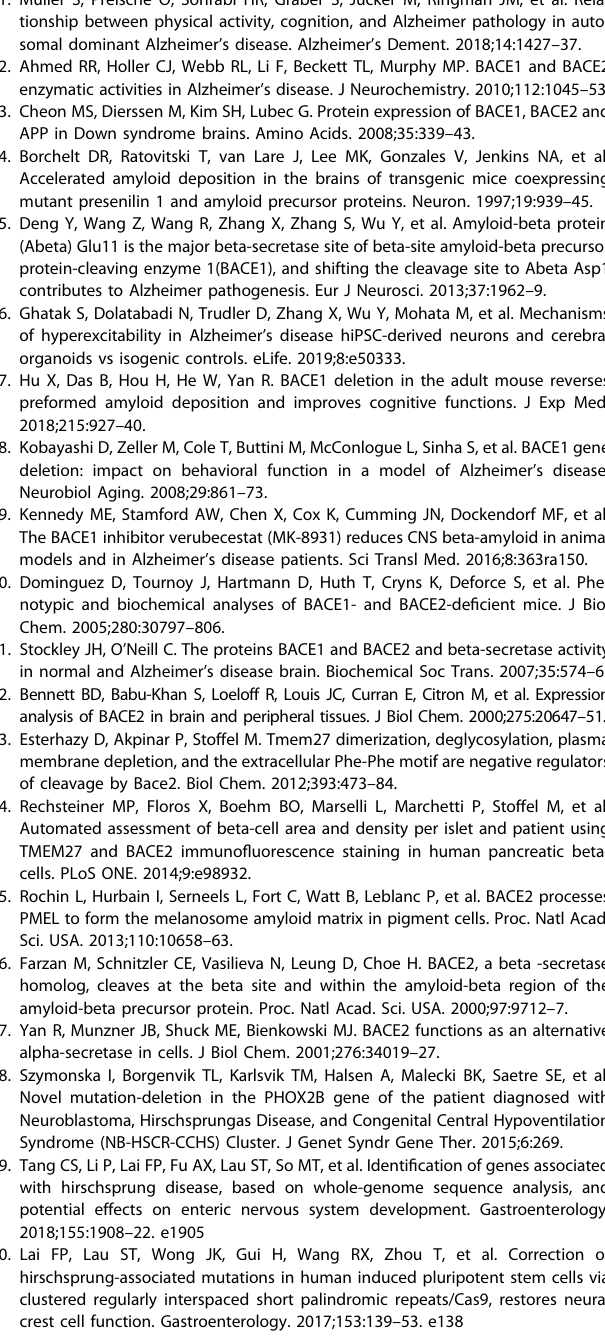
Fig. 5 BACE1/BACE2-APP signaling axis in HSCR and AD. Working model for illustrating the de fi ciency of BACE2-mediated APP cleavage may represent a common pathological mechanism for both HSCR and